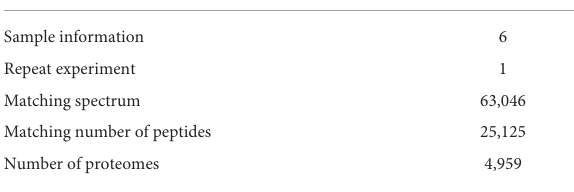
TABLE 5 The information of qualitative